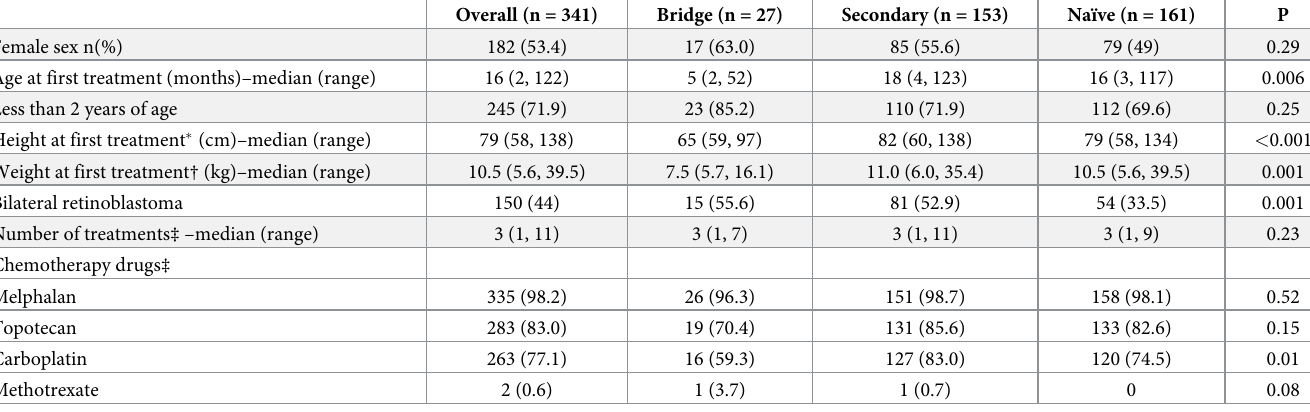
Table 1. Demographic and clinical characteristics, overall and by chemotherapy